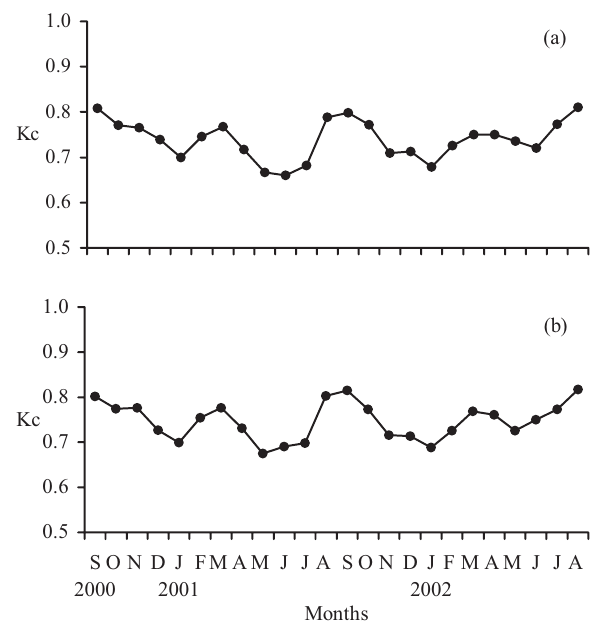
F IG . 2. – Monthly variation of Fulton condition factor (K (a) and female (b) round sardinella, Aegean Sea